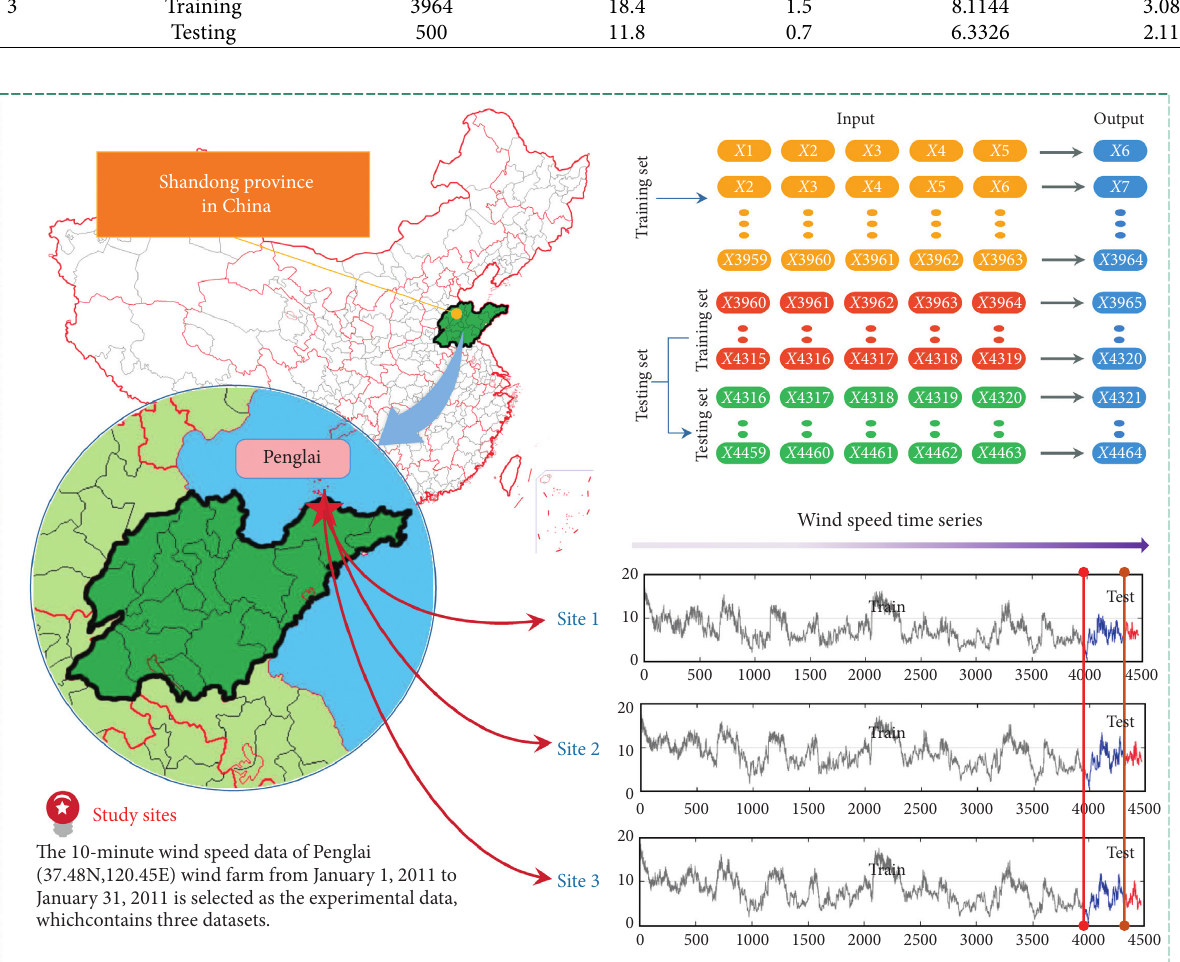
Figure 2: Description of observations in three datasets. On the left is the geographic location obtained by data points. The right part of the graph shows the dividing method of training set and testing set.